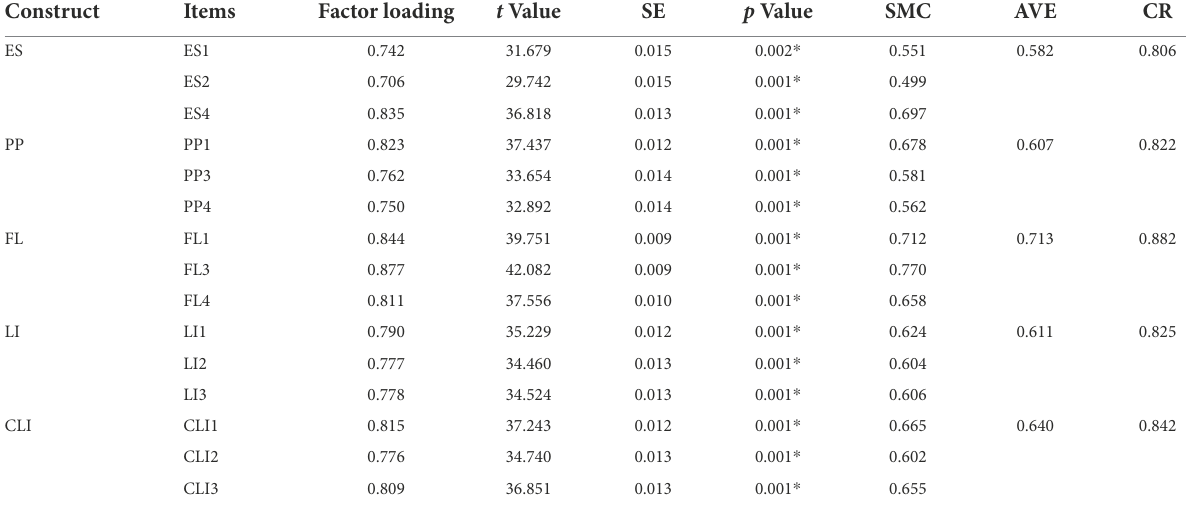
TABLE 5 Results of the convergent validity test.